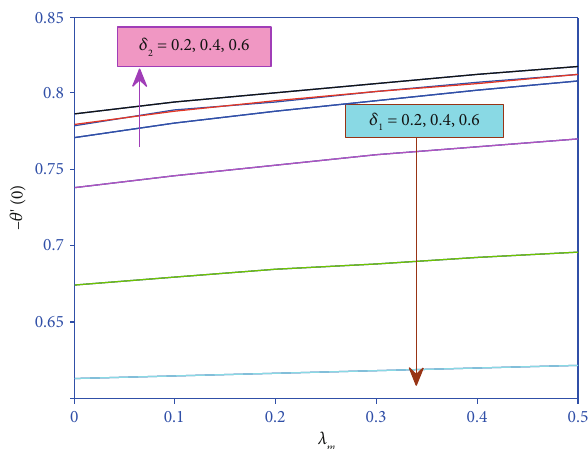
Figure 30: E ff ects of thermal and solutant strati fi cation parameters on the mass transfer rate.